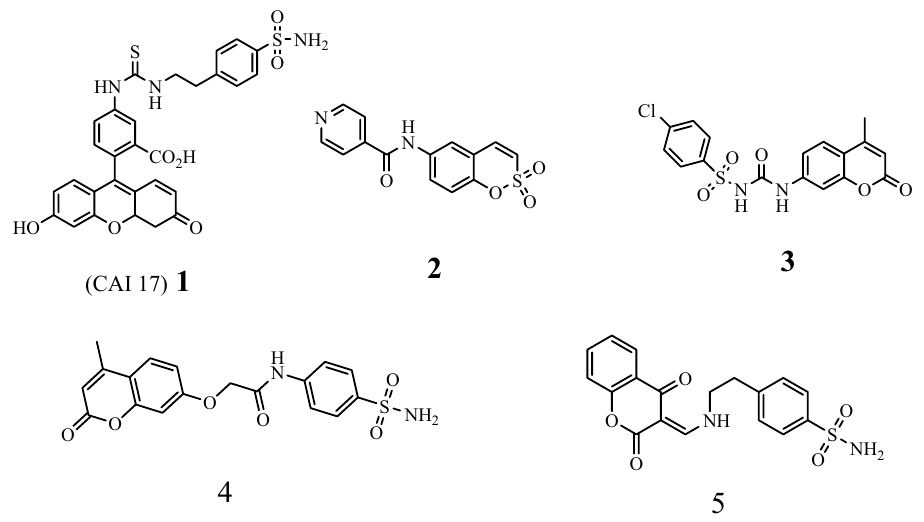
Figure 1. Structure of biologically active coumarin-sulfonamide hybrids.